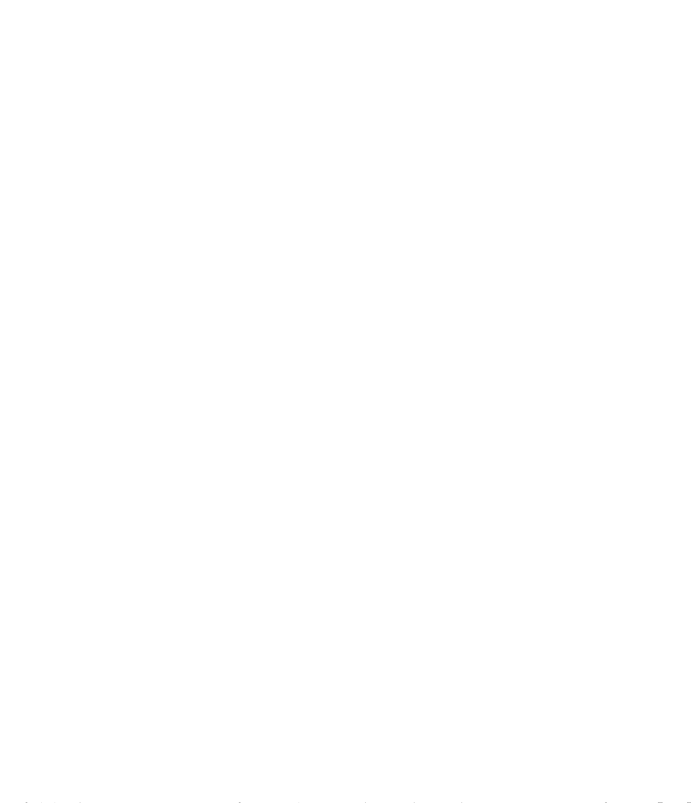
Figure 2. XPS C 1s spectra of ( a ) the pristine PU foam, ( b ) the PU foam after step 1 (t e/n = 10 min), (reproduced with permission from [25]), and ( c ) the PU foam after the two-step plasma process (t e/n = 10 min, t d = 10 min).